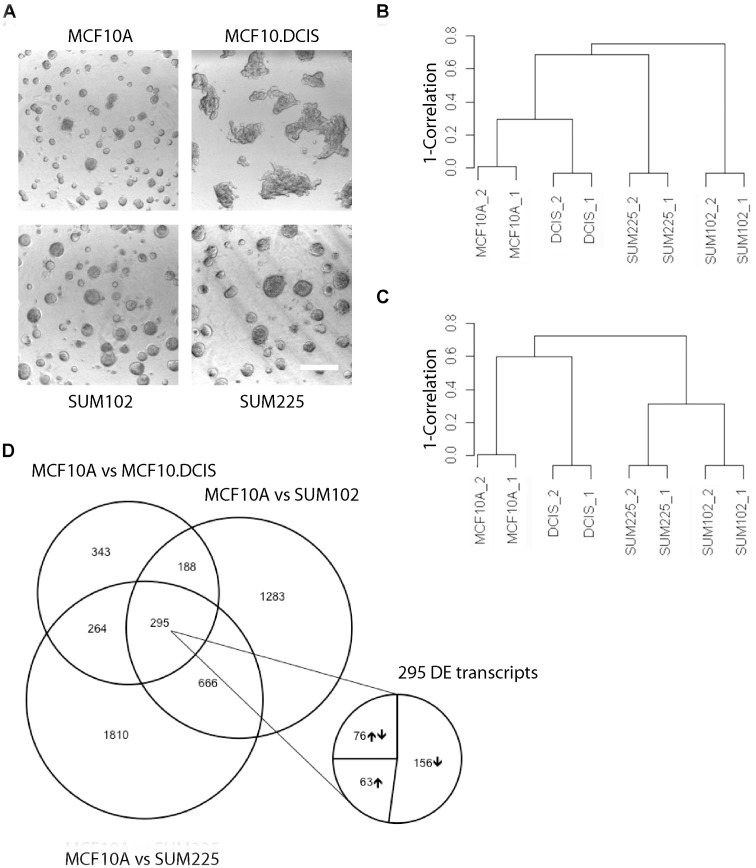
RNA-Seq analysis of MCF10A and DCIS models (A) Differential interference contrast (DIC) images of 12-day 3D rBM overlay cultures of MCF10A, MCF10.DCIS, SUM102, and SUM225 cells.Scale bar, 200 µm. (B) Unsupervised hierarchical clustering of the transcript profile from the eight RNA-Seq samples. (C) Cluster dendrogram of RNA-Seq samples based on differentially expressed genes. (D) Venn diagram of differential expression results (with a p-value <0.001 and cut-off fold change of 4) showing the overlap between the genes expressed by different models of DCIS in comparison to MCF10A. There are a total of 295 genes that are consistently differentially expressed between the MCF10A and the three DCIS models: MCF10.DCIS, SUM102 and SUM225. The expansion shows that 156 transcripts were decreased, 63 transcripts were increased, and 76 transcripts were differentially expressed in all three models but the direction of change was variable.